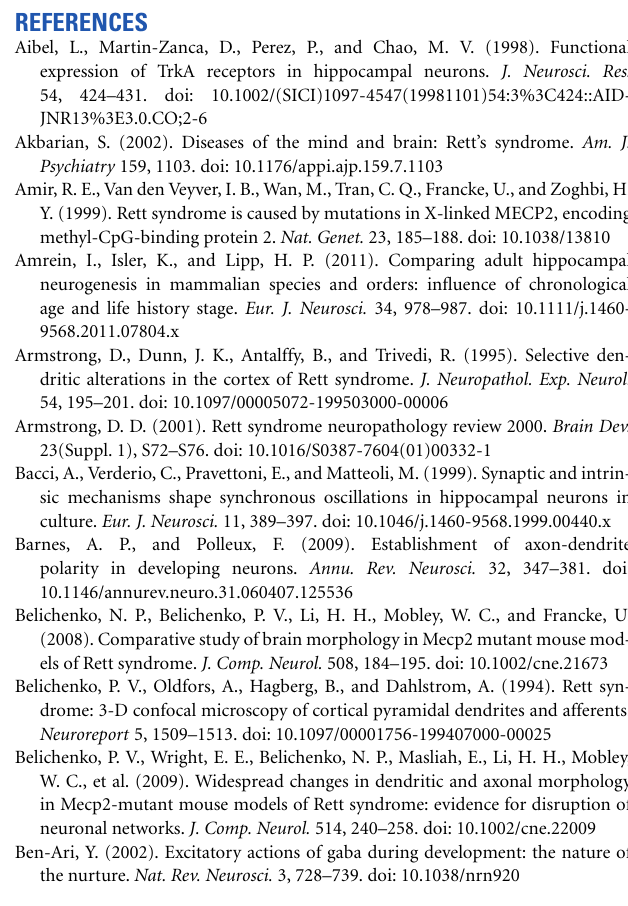
Figure S1 | Representative traces of spontaneous electrical activity in rat neurons at DIV12. Before (upper trace) and after (bottom trace) 10min superfusion with